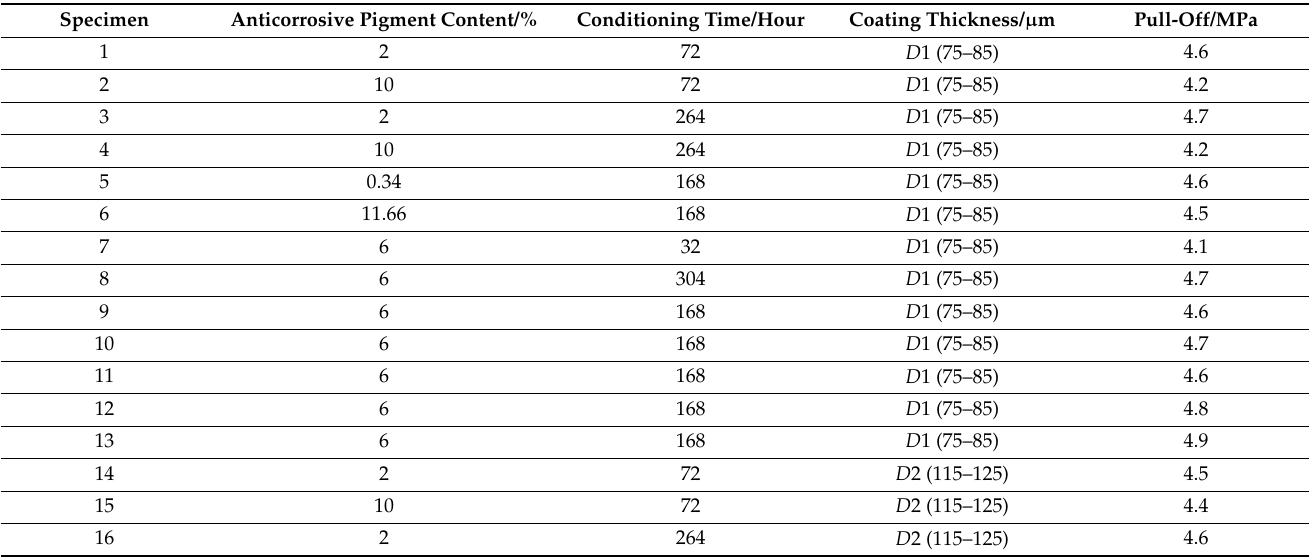
Table 3. Results of the pull-off